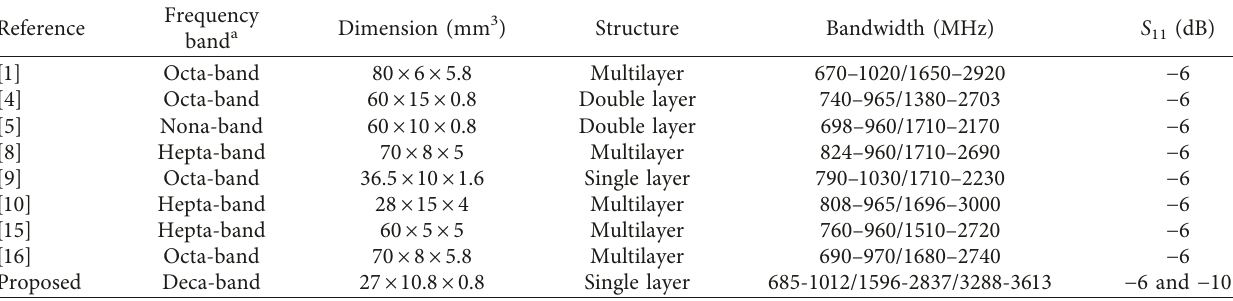
Table 2: Comparison of the proposed antenna and reference